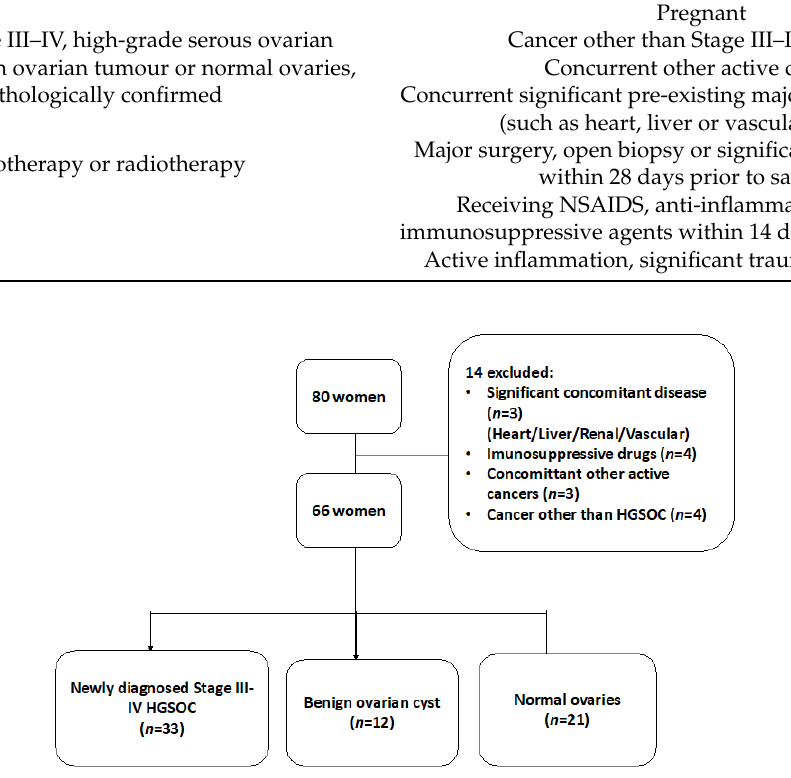
Figure 1. A flowchart of our cross-sectional study design for patients with suspected ovarian mass.